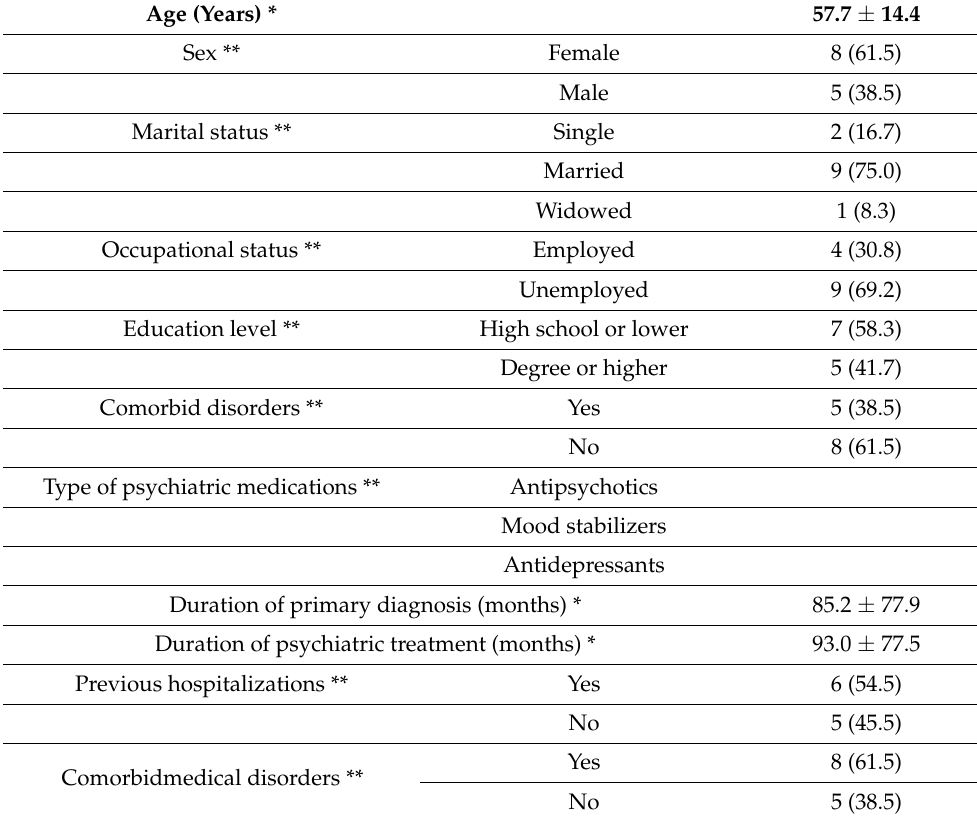
Table 1. Socio-demographic characteristics and clinical features of the group ( n =